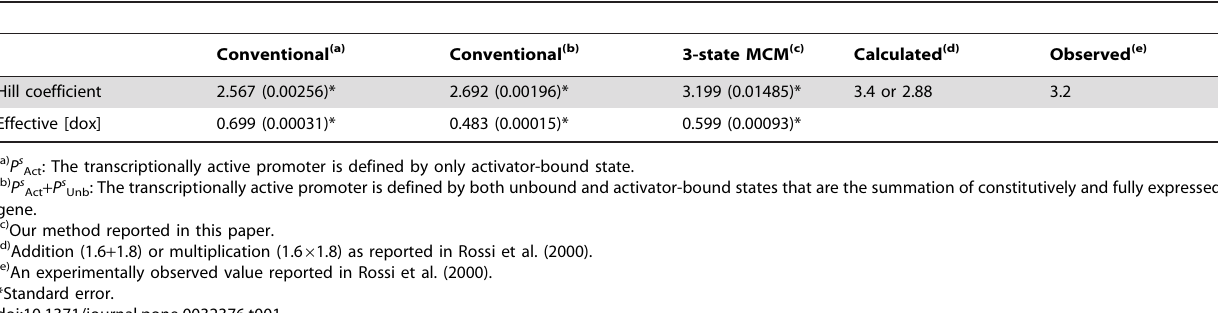
Table 1. Comparisons of the predicted parameters of Hill function for gene induction mediated by two competing factors (A + R).